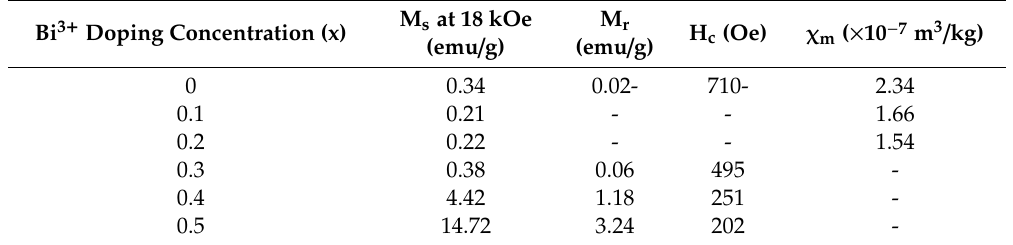
Table 3. Specific magnetization (M s ), mass magnetic susceptibility ( χ m ), remanent magnetization (M r ) and coercive field (H c ) for Bi doped YFeO 3 .